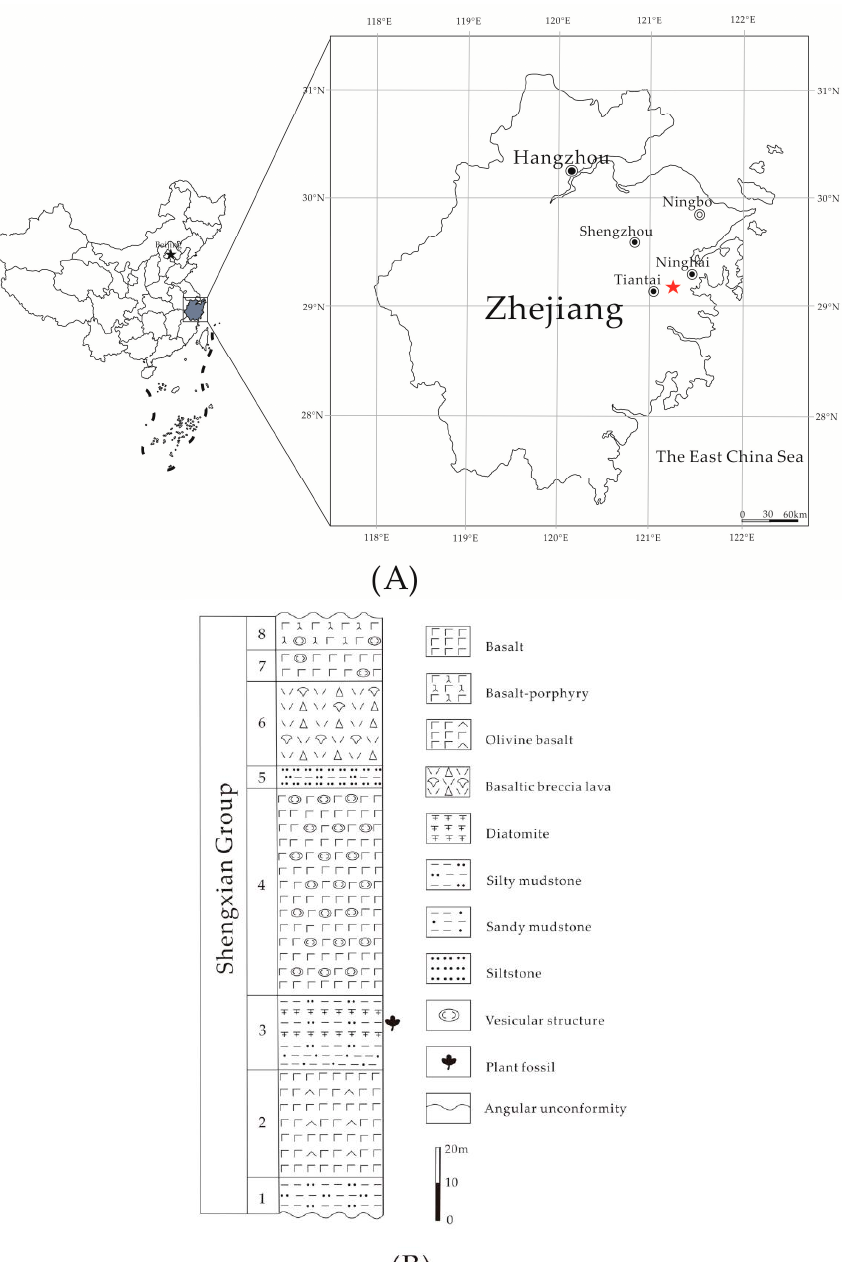
Figure 2. ( A ) Fossil site (red pentagram) of present fossil. ( B ) Stratigraphic column of the Shengxian Formation in eastern Zhejiang, China.